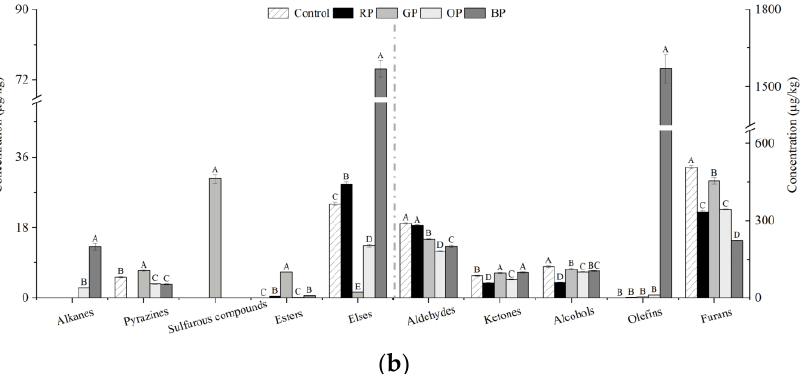
Figure 5. Concentration of volatile compounds. ( a ) Total relative contents of volatile compounds in spices; ( b ) concentrations of volatile compounds in extrudates. OP: Onion powder; RP: Red pepper powder; BP: Black pepper; GP: Garlic powder; Columns with different letters (A – D) indicate significant difference between samples (α = 0.05 level).